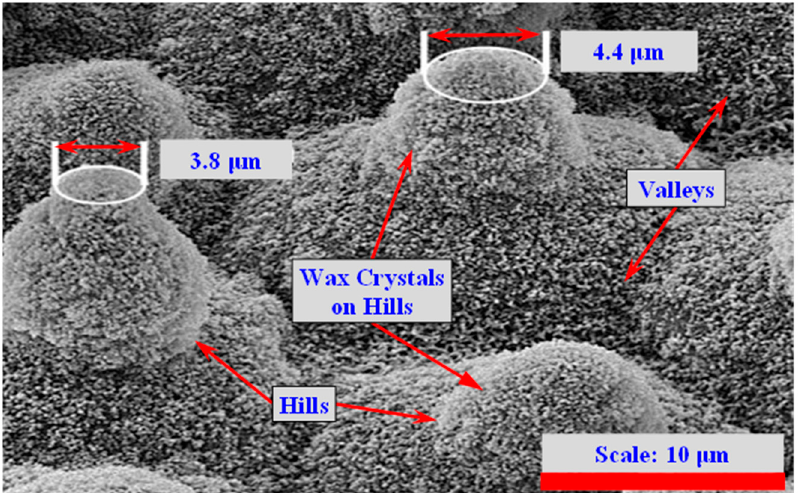
Figure 3. An SEM image of the lotus leaf (modified from Ensikat et al. [28]). This image depicts the microscale structure comprising hills with the valleys among them, as well as the nanoscale wax crystals. The diameters of two mountain peaks are also shown.